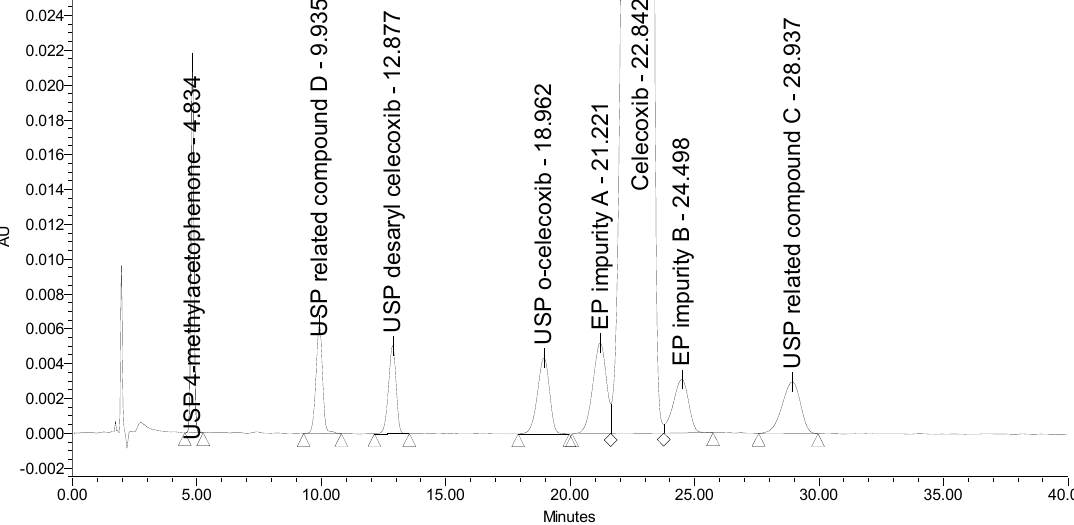
Figure 2. A chromatogram of celecoxib at a concentration of 0.5 mg / mL spiked with EP impurity A, EP impurity B, USP related compound C, USP related compound D, USP o-celecoxib, USP desaryl celecoxib, and USP 4-methylacetophenone at the 0.5% level obtained using the EP method.